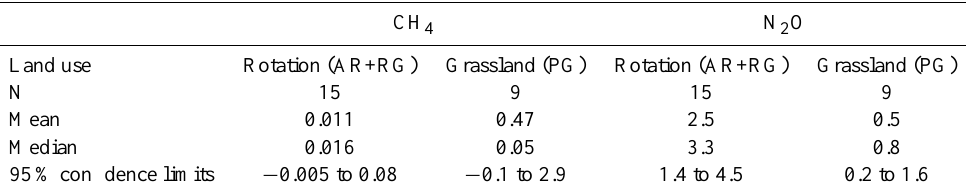
Table 8. Annual emission factors (gm − 2 ) for CH 4 and N 2 O were calculated for soils in rotation (land use categories AR and RG in this study) and permanent grassland (PG), respectively, using experimental block (paired sampling points) as the basic unit. CH 4 N 2 O Land use Rotation (AR+RG) Grassland (PG) Rotation (AR+RG) Grassland (PG) N 15 9 15 9 Mean 0.011 0.47 2.5 0.5 Median 0.016 0.05 3.3 0.8 95% confidence limits − 0.005 to 0.08 − 0.1 to 2.9 1.4 to 4.5 0.2 to